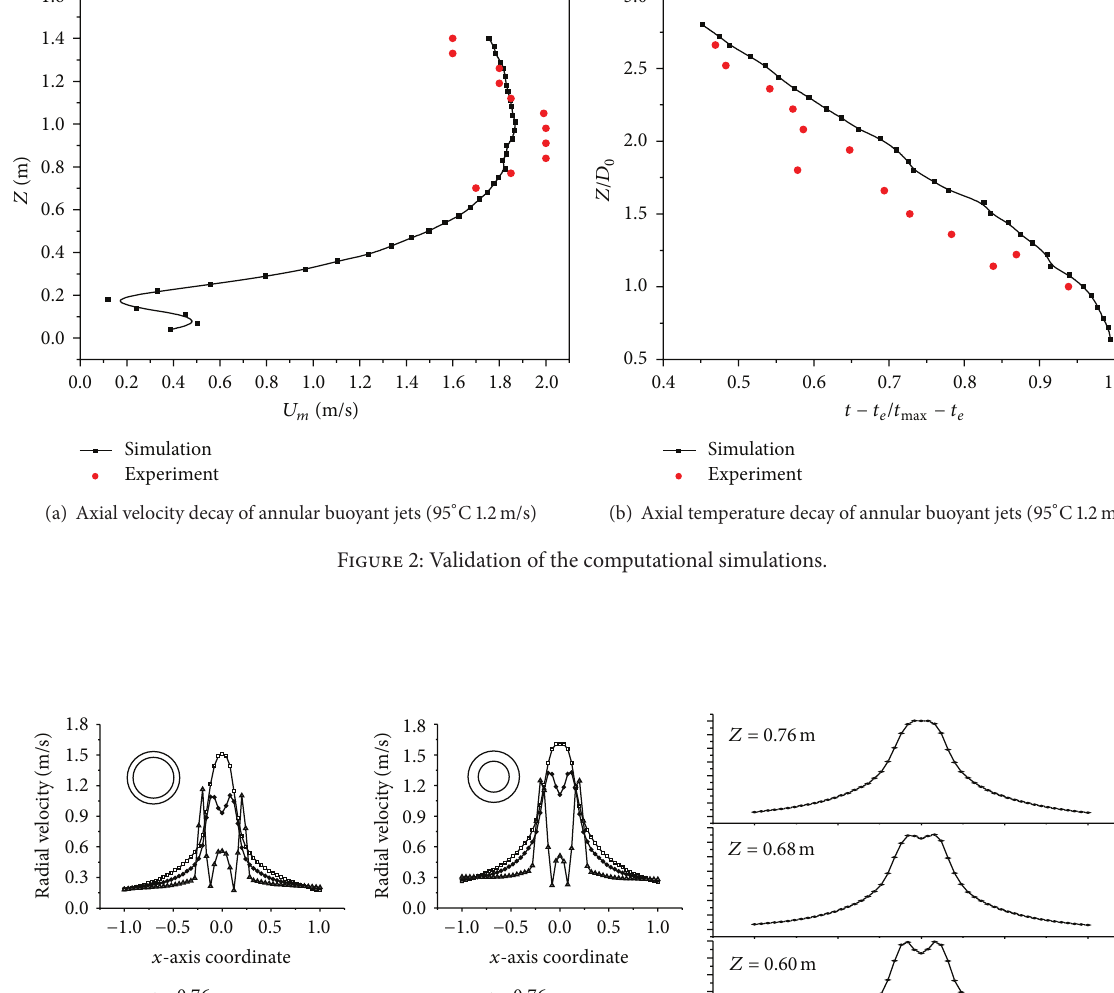
Figure 3: Variation of radial velocity distribution of four annular jet